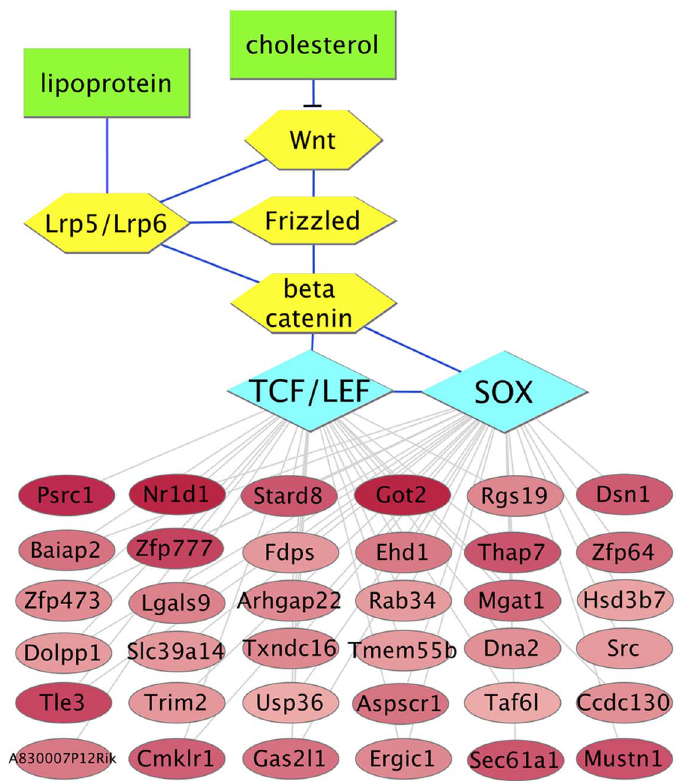
Figure 4. Predicted molecular interaction network for upregulated genes that possess CTTTGA elements connects cholesterol to motility. Red ellipses represent genes whose expression levels are elevated in plaque macrophages from Mttp -inactivated vs. vehicle-treated animals (darker color indicates a greater differential expression ratio; see Table S2). Yellow hexagons and blue edges represent the upstream signaling pathway based on the literature (the blunt-ended edge indicates inhibition of signaling), with green rectangles representing lipids ( cholesterol : membrane cholesterol; lipoprotein : apoB-containing lipoprotein). Blue diamonds represent transcription factor binding site motifs. Gray edges connect the transcription factors to the downstream genes that possess corresponding binding site sequence